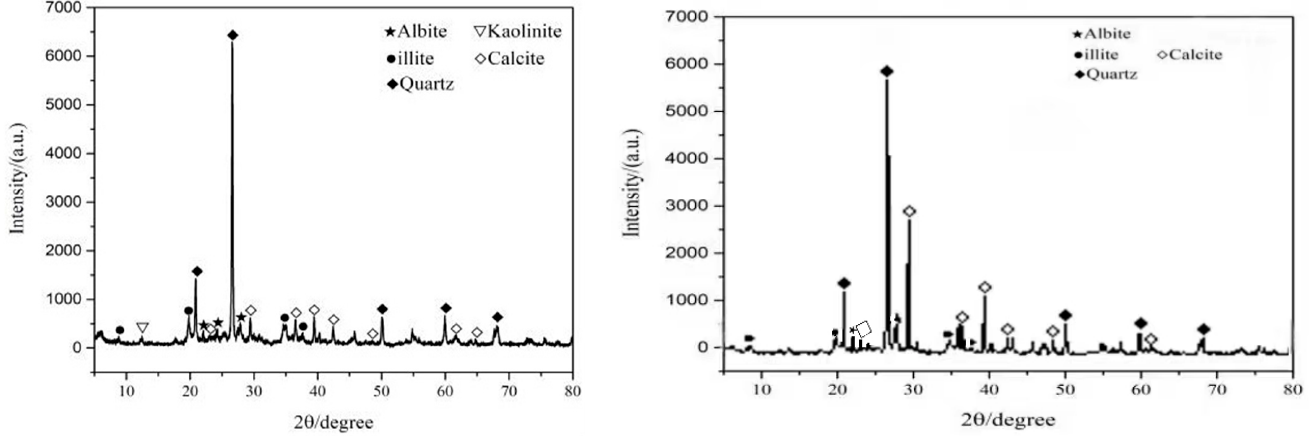
Figure 2. X-ray diffraction results.